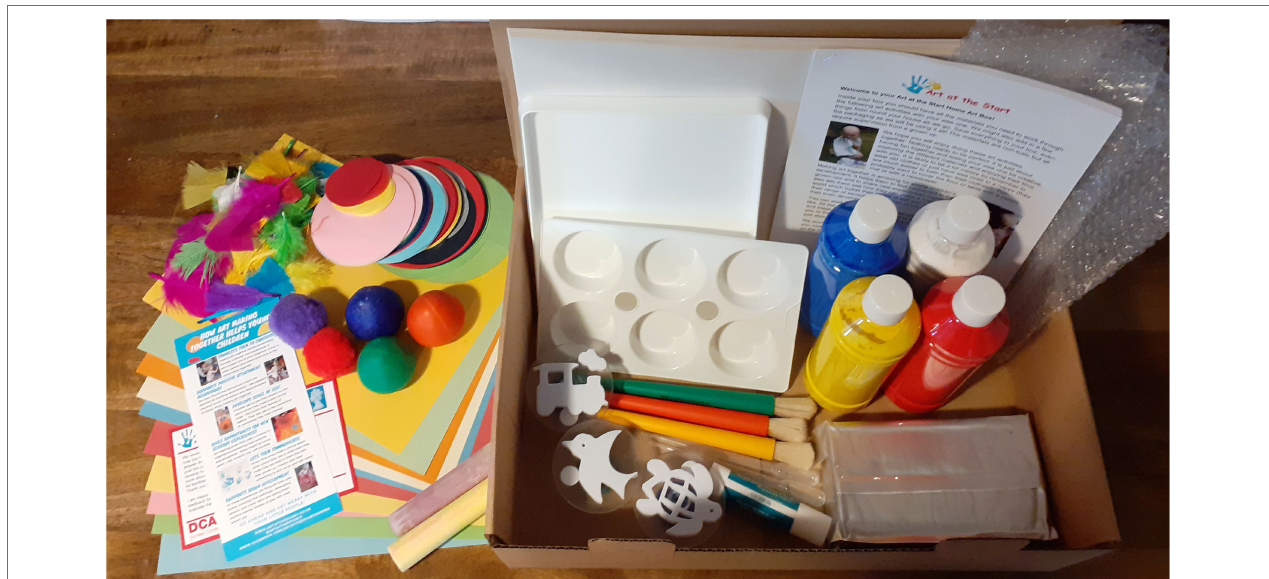
FIGURE 3 | Contents of an Art